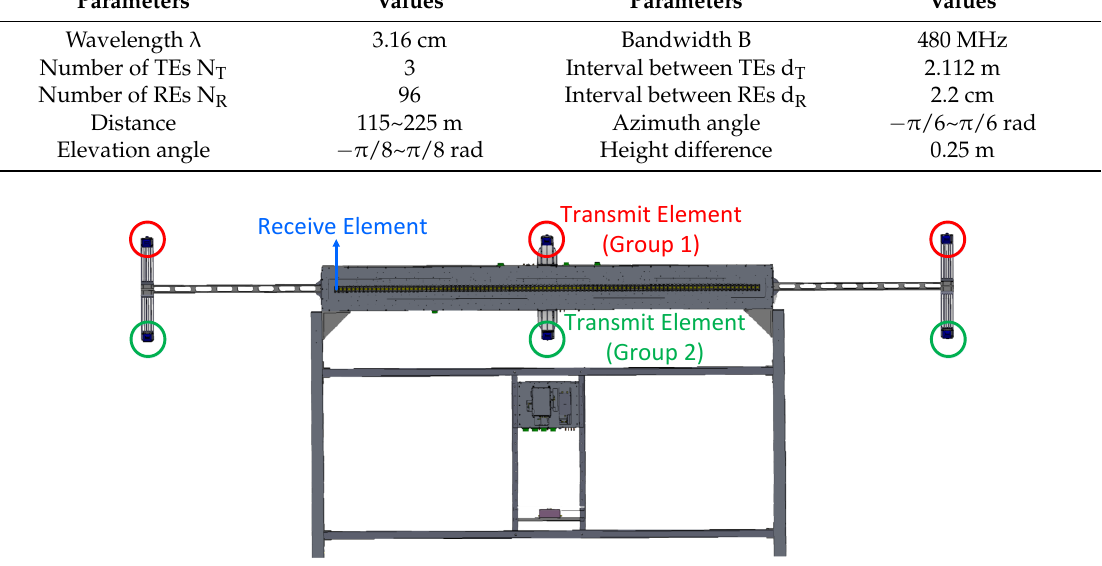
Figure 17. MIMO radar system for the experiment.